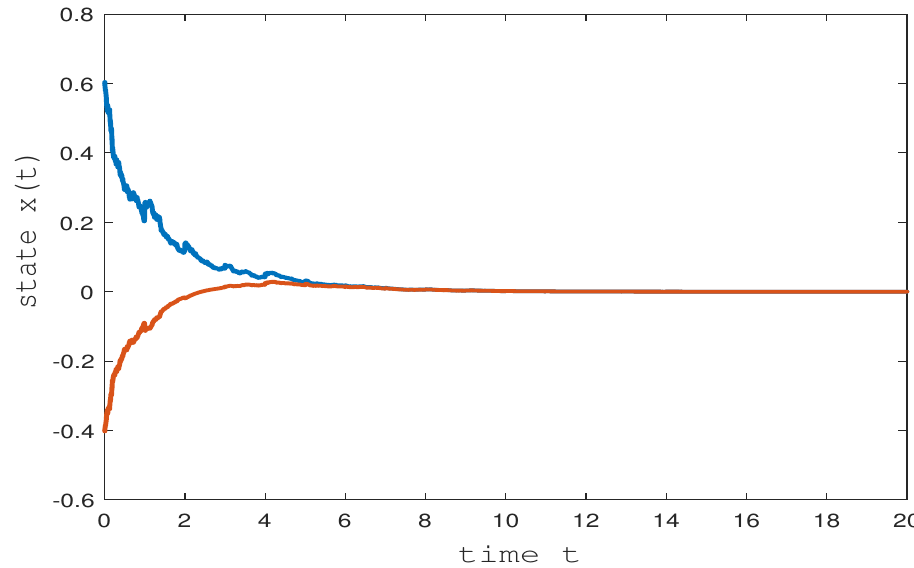
Figure 3. State trajectories of (46) under destabilizing impulsive